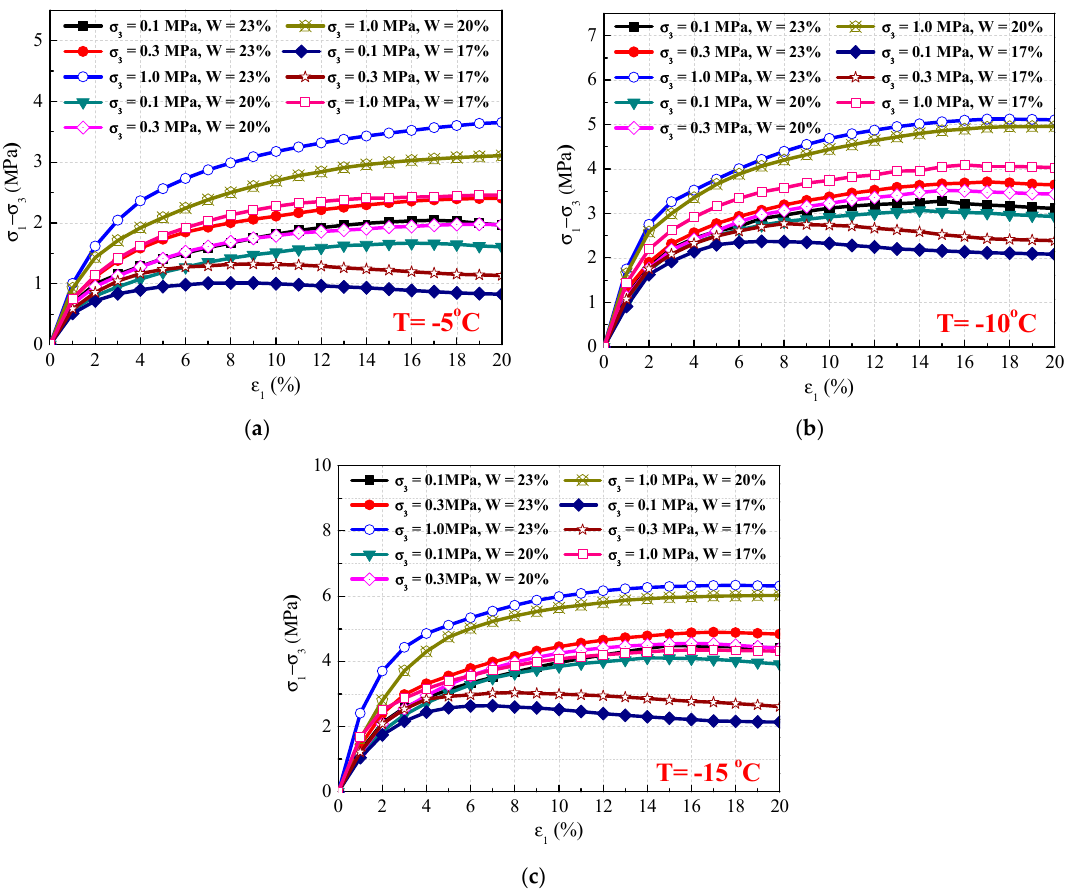
Figure 5. Stress–strain ( σ 1 – σ 3 and ε 1 ) curves of frozen silty clay under different temperatures. ( a ) T = − 5 ◦ C; ( b ) T = − 10 ◦ C; ( c ) T = − 15 ◦ C.